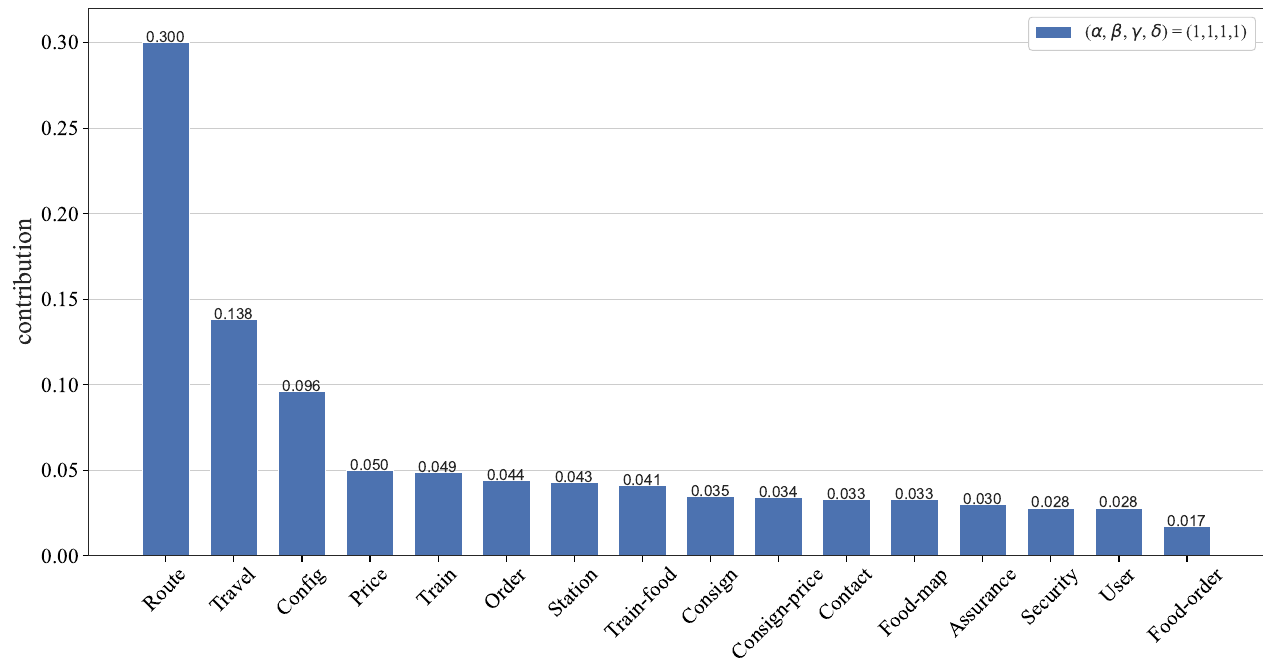
Figure 9. The database contributions to business scenarios in TrainTicket